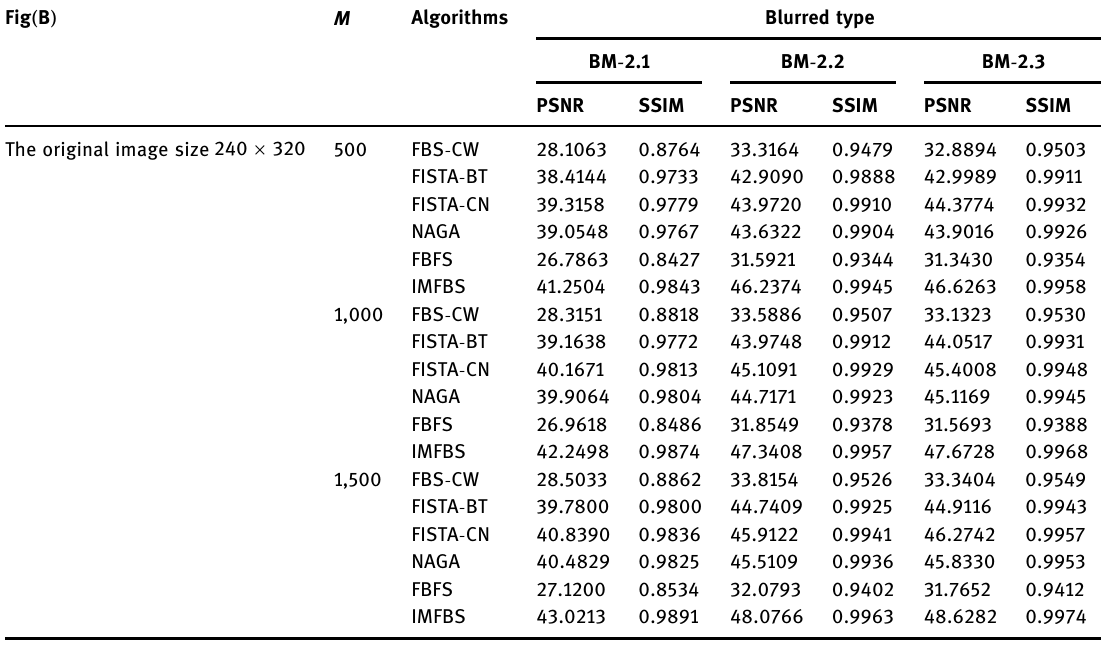
Table 3: The results of deblurred images for each algorithm Fig ( B )